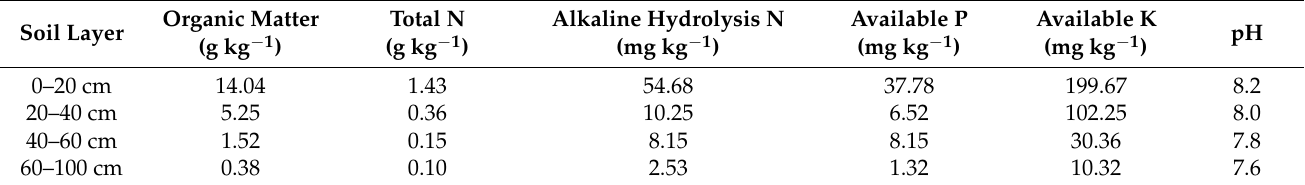
Table 1. Basic properties of the tested